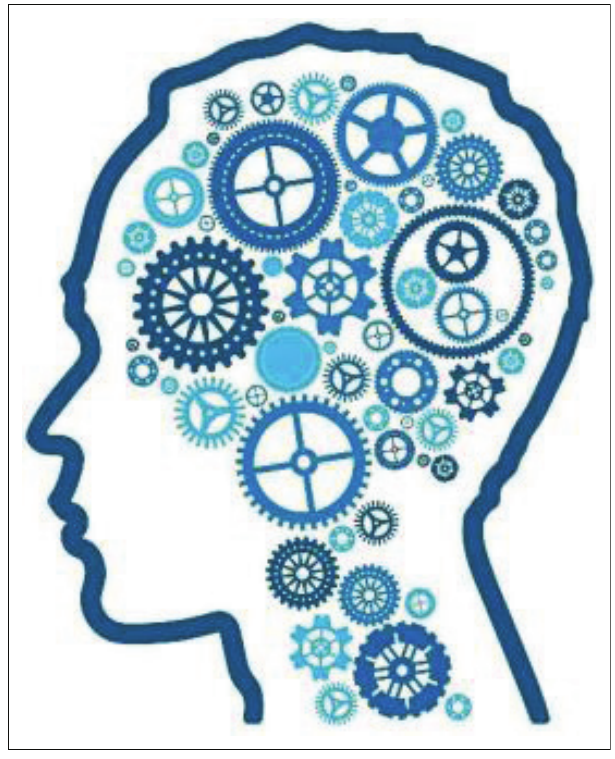
FIGURE 1-A1: Team Sisonke: ‘Providing care for the carers. Taking steps to guard against health care worker burnout in the face of the COVID-19